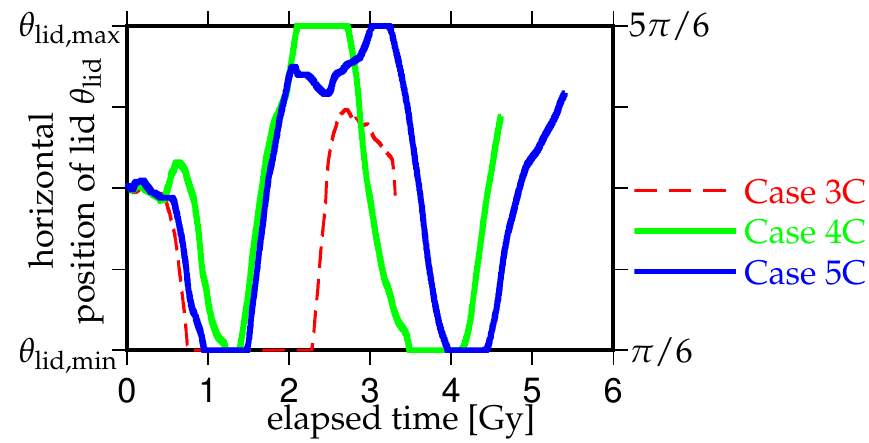
Figure 10. Same as Figure 2, but for Cases 3C to 5C where the continental lid is initially positioned at the center of the top surface ( θ lid = ( θ min + θ max ) /2 = π